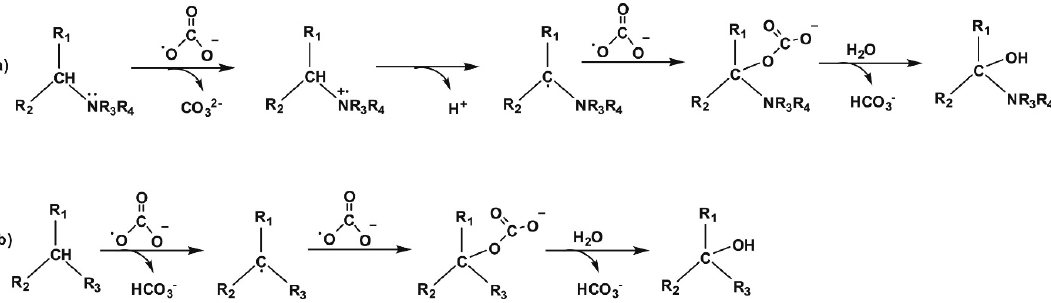
Figure 2. Hydroxylation by an electron transfer ( a ) and hydrogen abstraction ( b ) mechanism initiated by CO 3 ●− . Reprinted with permission from [58].